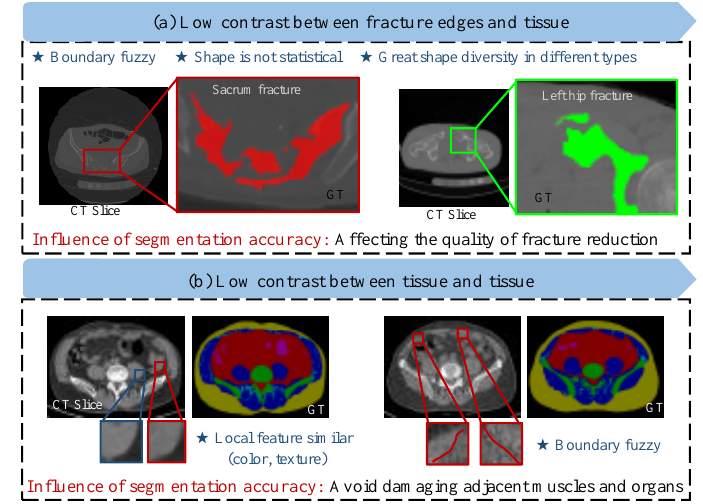
Figure 1. Some difficult samples of pelvic CT slices. ( a ) Low contrast between fracture edges and tissue. ( b ) Low contrast and local similarity between tissue and tissue. The boxes are the “interested region”, and the colors used are their corresponding GT marking color. The difficulties of segmen- tation are listed with asterisks.